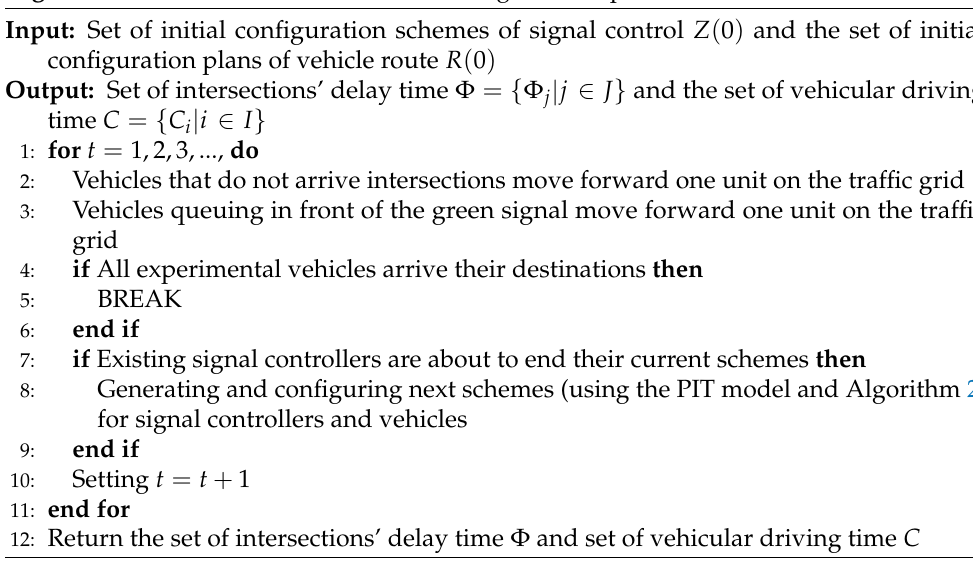
Algorithm 3 Pseudo-code for vehicles driving in the